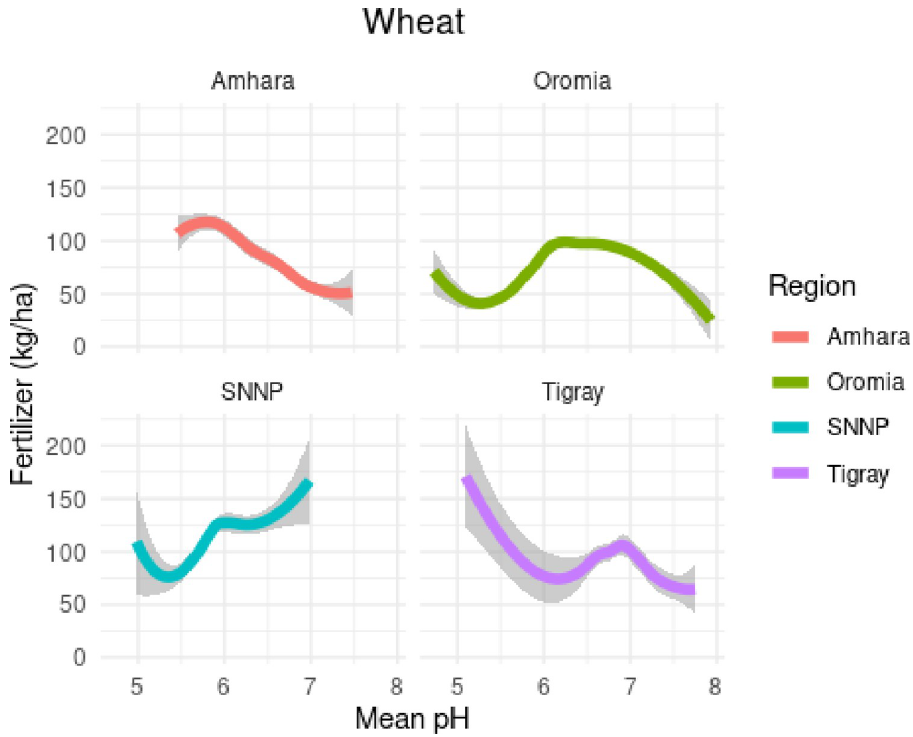
Fig 3. Estimated relationship between fertilizer use and soil pH for